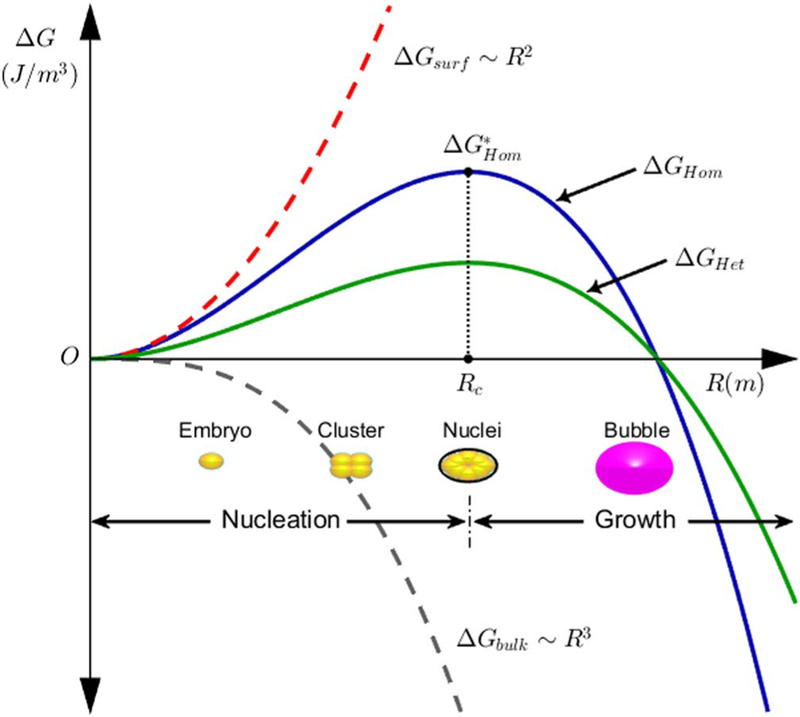
Gibbs free energy change during bubble nucleation. The surface free energy ΔGsur f (dashed red line), bulk free energy ΔGbulk (dashed black line), homogeneous nucleation free energy ΔGHom (blue line), and the heterogeneous nucleation free energy ΔGHet (green line) are presented as a function of the radius R. The nucleation stages are also sketched for reference. The embryo and cluster states are reversible and the nuclei state is irreversible. Beyond the nuclei phase the bubble starts growing.